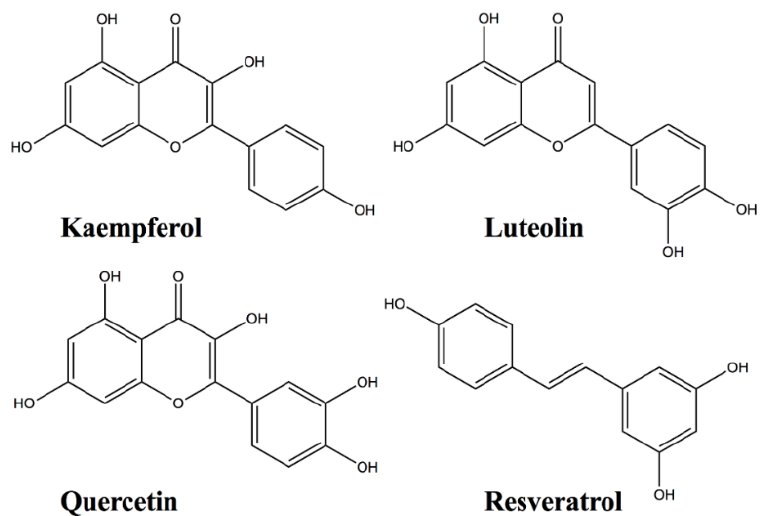
Figure 1. Chemical structure of the flavonoids used in this study.